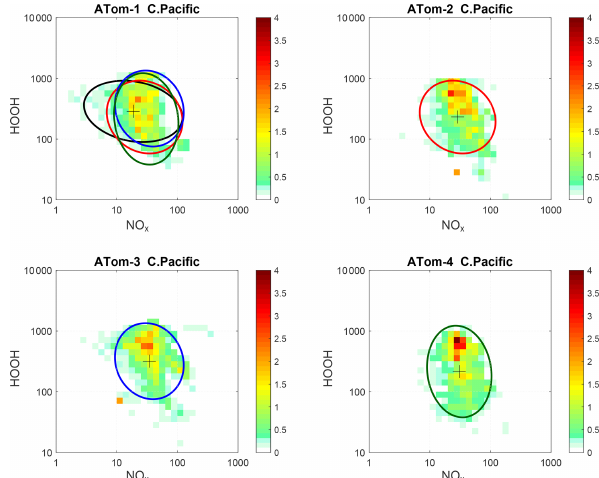
Figure 7. 2D frequency of occurrence (PDs in log ppt mole frac- tion) of HOOH vs. NO x for the tropical central Pacific for all four ATom deployments. The cross marks the mean (in log space), and the ellipse is fitted to the rotated PD having the smallest semi-minor axis. The semi-minor and semi-major axes are 2 standard deviations of PD in that direction. The ellipses from ATom-2 (red), ATom- 3 (blue), and ATom-4 (dark green) are also plotted in the ATom-1